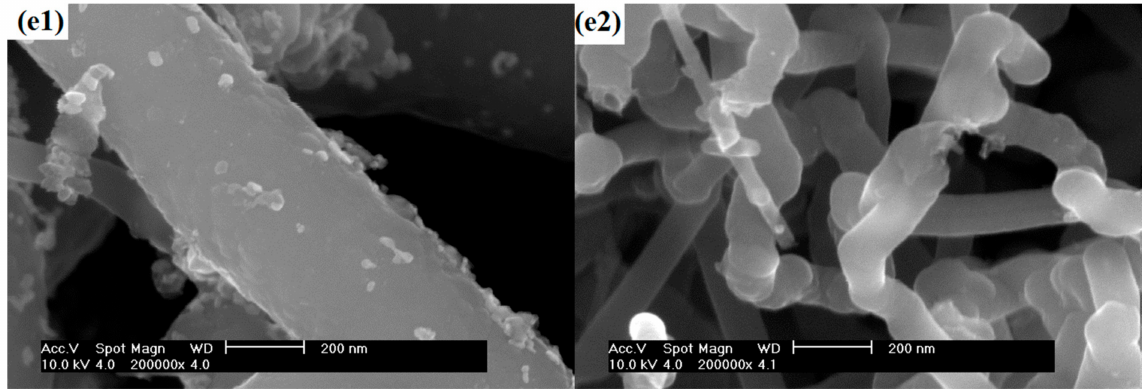
Figure 2. SEM images of ( a1 ): Co/CNT, ( a2 ): CNT, ( b1 ): Co/AC, ( b2 ): AC, ( c1 ): Co/GO, ( c2 ): GO, ( d1 ): Co/rGO, ( d2 ): rGO, ( e1 ): Co/CNF, ( e2 ): CNF.